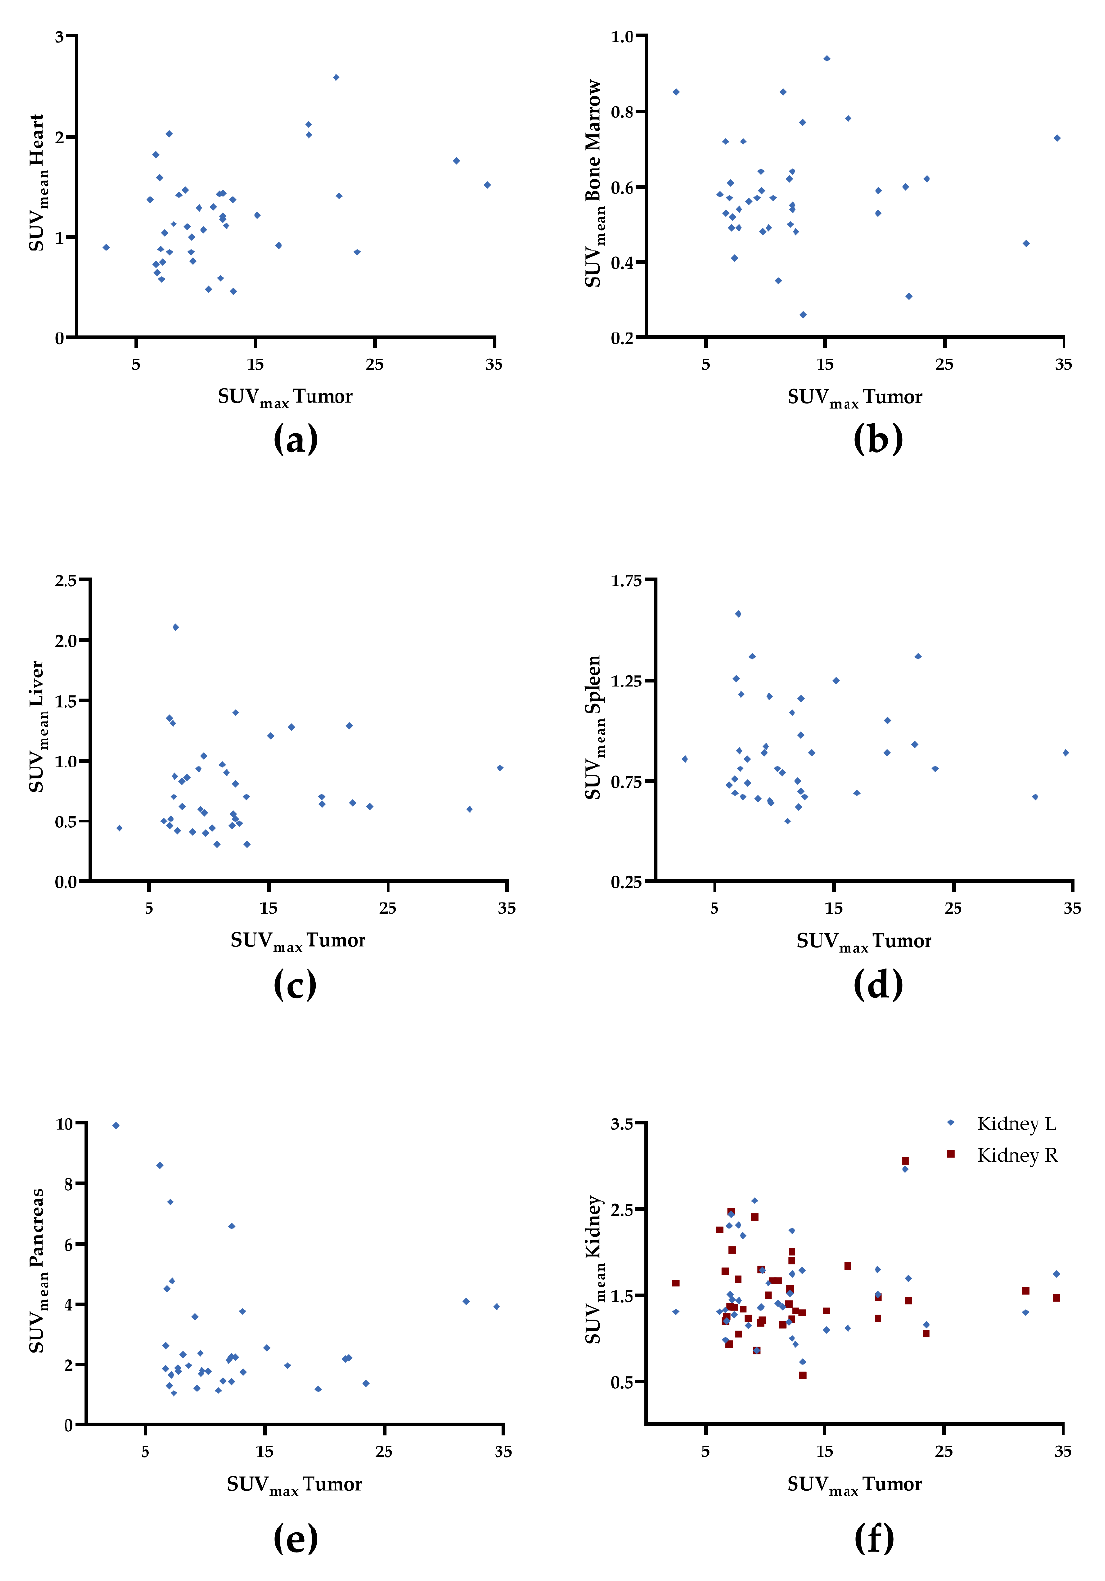
Figure 1. Correlative plots of tumor-derived maximum standardized uptake values (SUV max ) and mean standardized uptake values (SUV mean ) from organs: ( a ) heart; ( b ) bone marrow, ( c ) liver, ( d ) spleen, ( e ) pancreas, and ( f ) kidney. Rhombuses and squares are partially overlaid. No significance was reached. R = right. L = left.